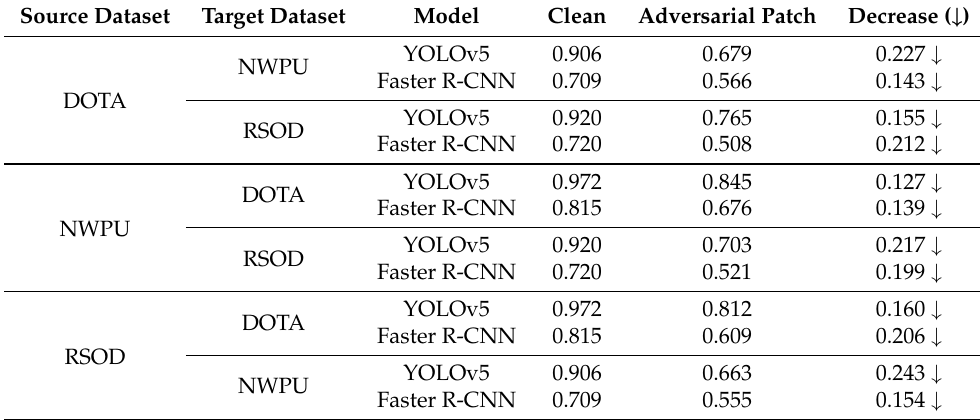
Table 5. Scenario C: Attack transferability of joint dataset-to-dataset and model-to-model.